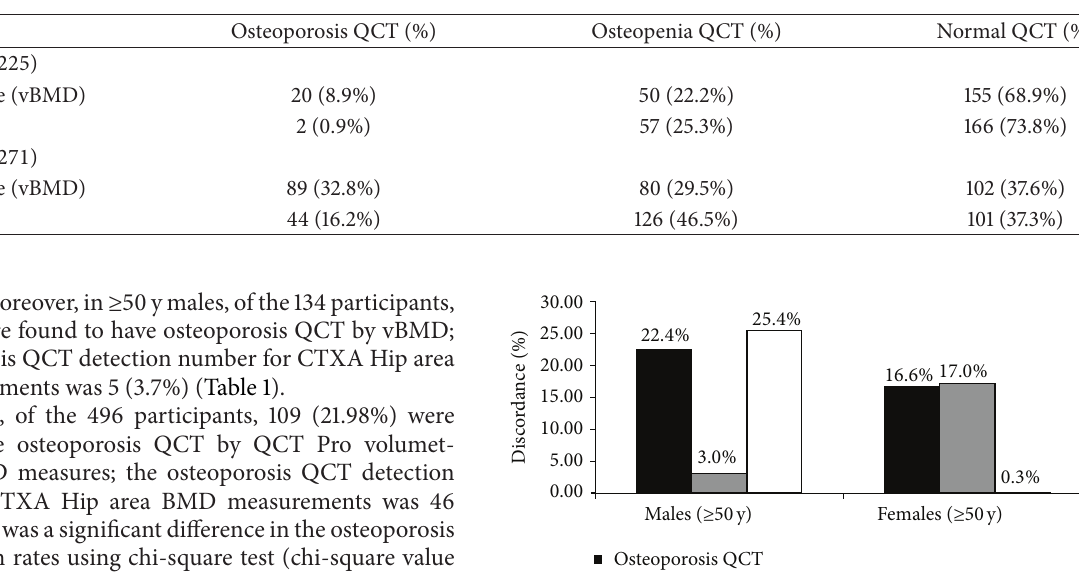
Table 2: The diagnostic rates classification with vBMD versus aBMD in females.